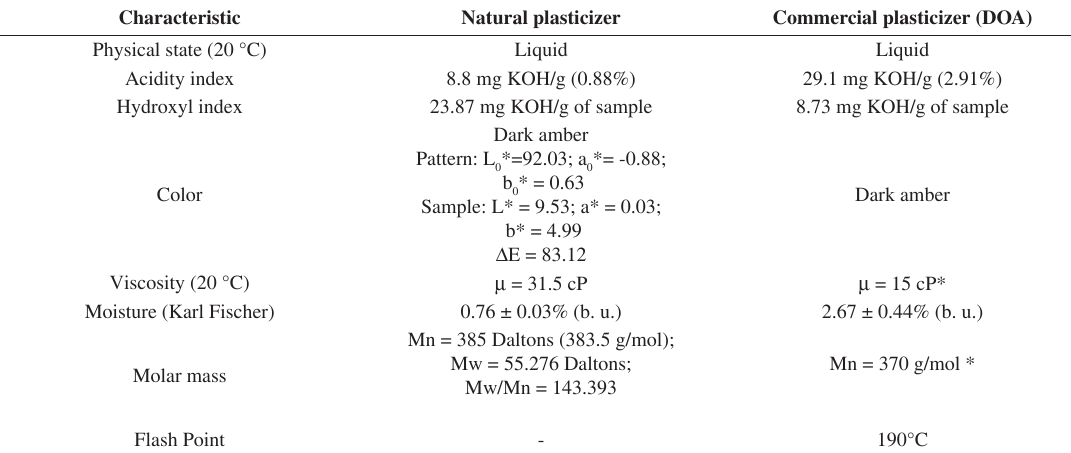
Table 2. Physical characteristics of natural and commercial